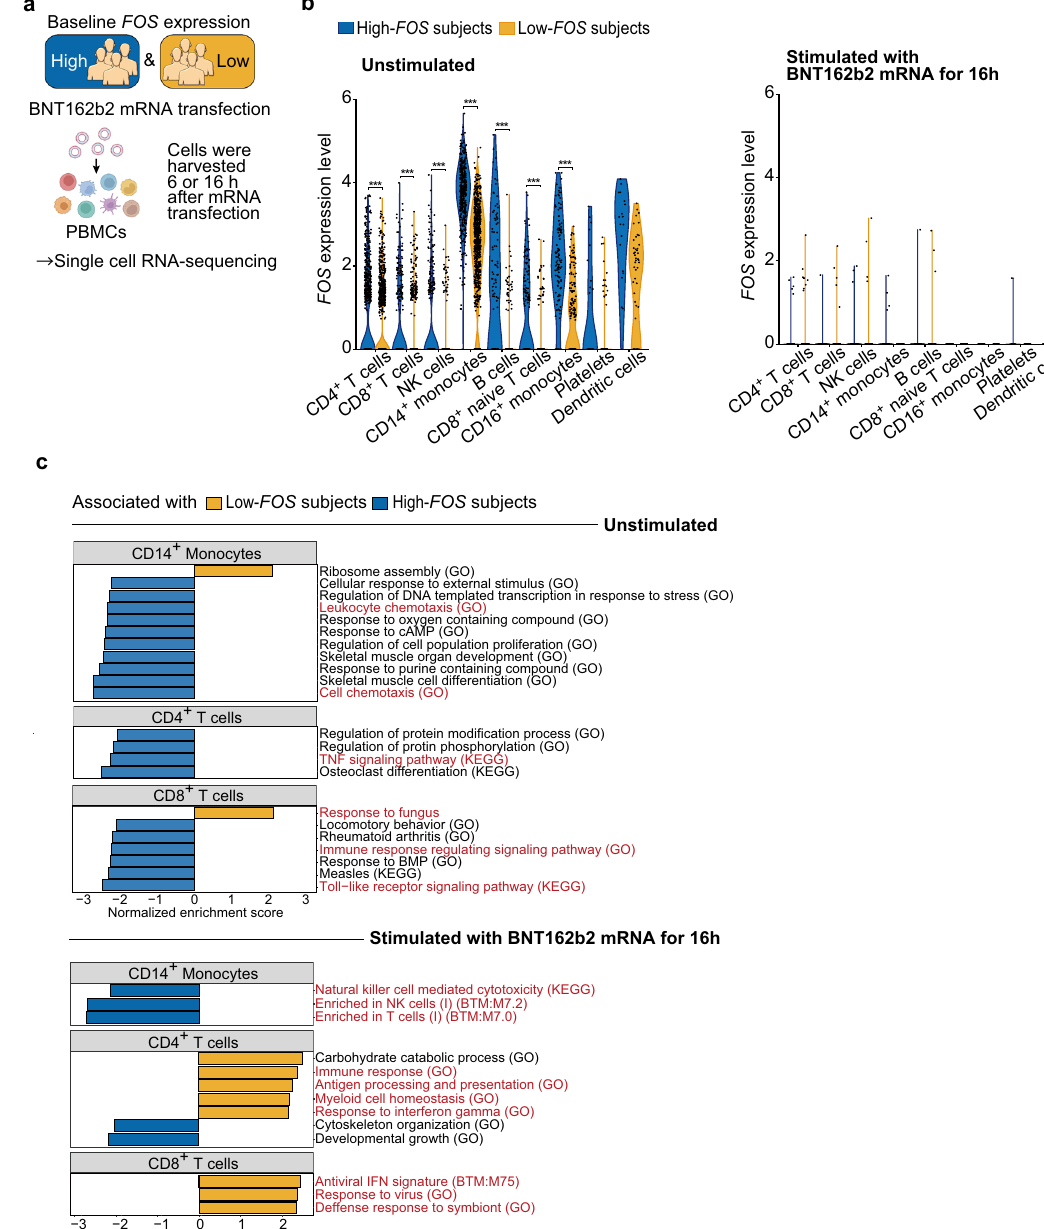
(GO)Carbohydrate catabolic process (GO) (GO)Immune response (GO)Antigen processing and presentation (GO)Myeloid cell homeostasis (GO)Response to interferon gamma (GO)Cytoskeleton organization Developmental growth